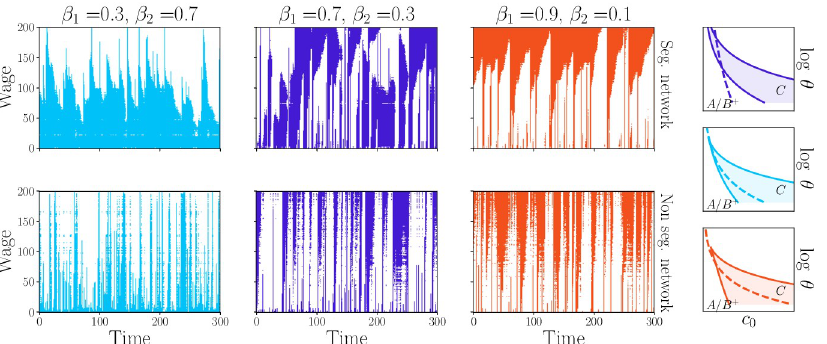
Fig 2. The graphs show the crises dynamics for three choices of the parameters, together with the relative phase diagram, using the same colour code. In the main panels, the abscissa is time and the ordinate are households, sorted by increasing wage. Colour appears when one agent’s consumption drops below its corresponding threshold. In the 3 right panels sketching the phase diagram, the dashed line indicate the boundaries of the C phase while the plain line represents the locus of c 0 and θ for different households. The three dynamics differ only by the choice of the couple ¼ 0 : 5 are kept constant, together with the level of income inequalities β 1 and β 2 , while the global levels of � y ¼ 4 and � c 0 μ = 1.5. For the upper set of graphs, the network is segregated, λ = 0.01, while the bottom ones are with λ = 100. Note that the typology of crises changes substantially between the two